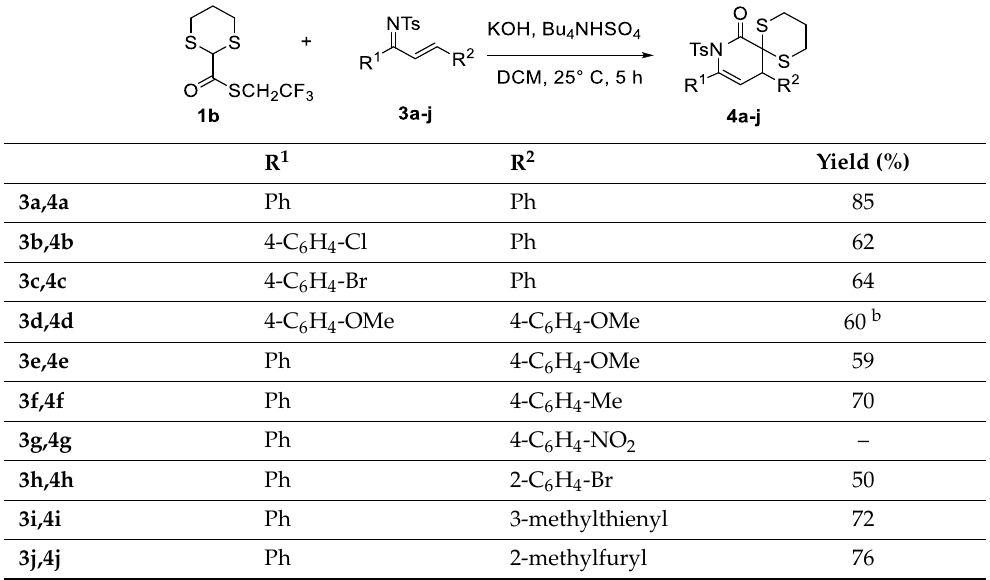
Table 2. Synthesis of 3,4-dihydropyridin-2-ones 4a – j a .